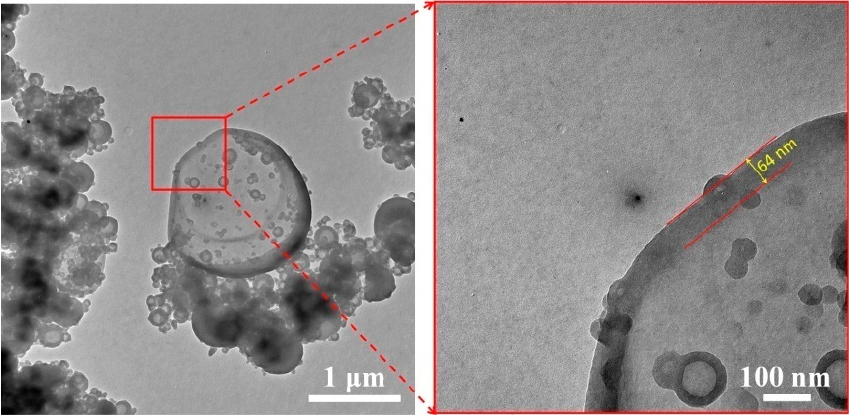
Figure 5. TEM micrographs of Micro/NanoPCMs microencapsulated comb-like polymeric PCMs.